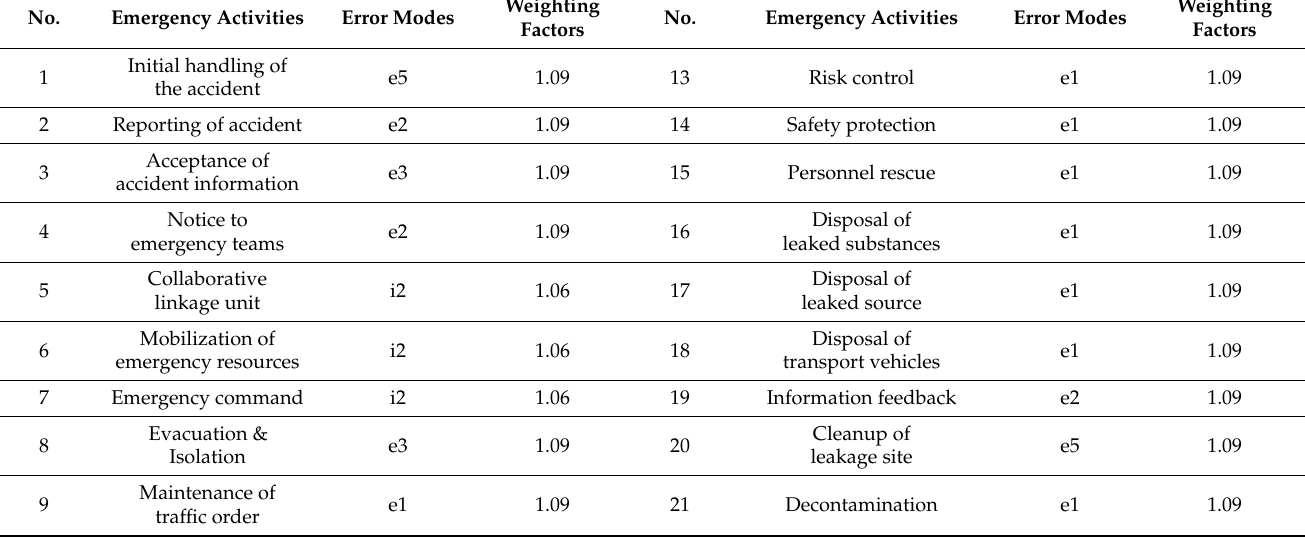
Table 8. Twenty-four emergency activity weighting